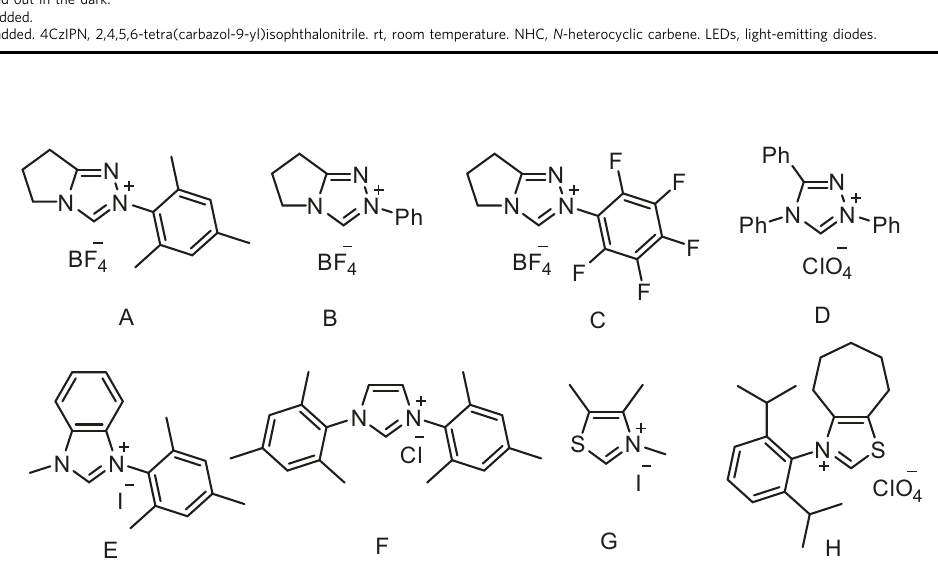
Fig. 2 Different NHC catalysts tested. A – D are precursors leading to triazol-5-ylidene-type carbenes, E and F provide imidazole-2-ylidines, and G and H deliver thiazol-2-ylidenes. NHC N-heterocyclic